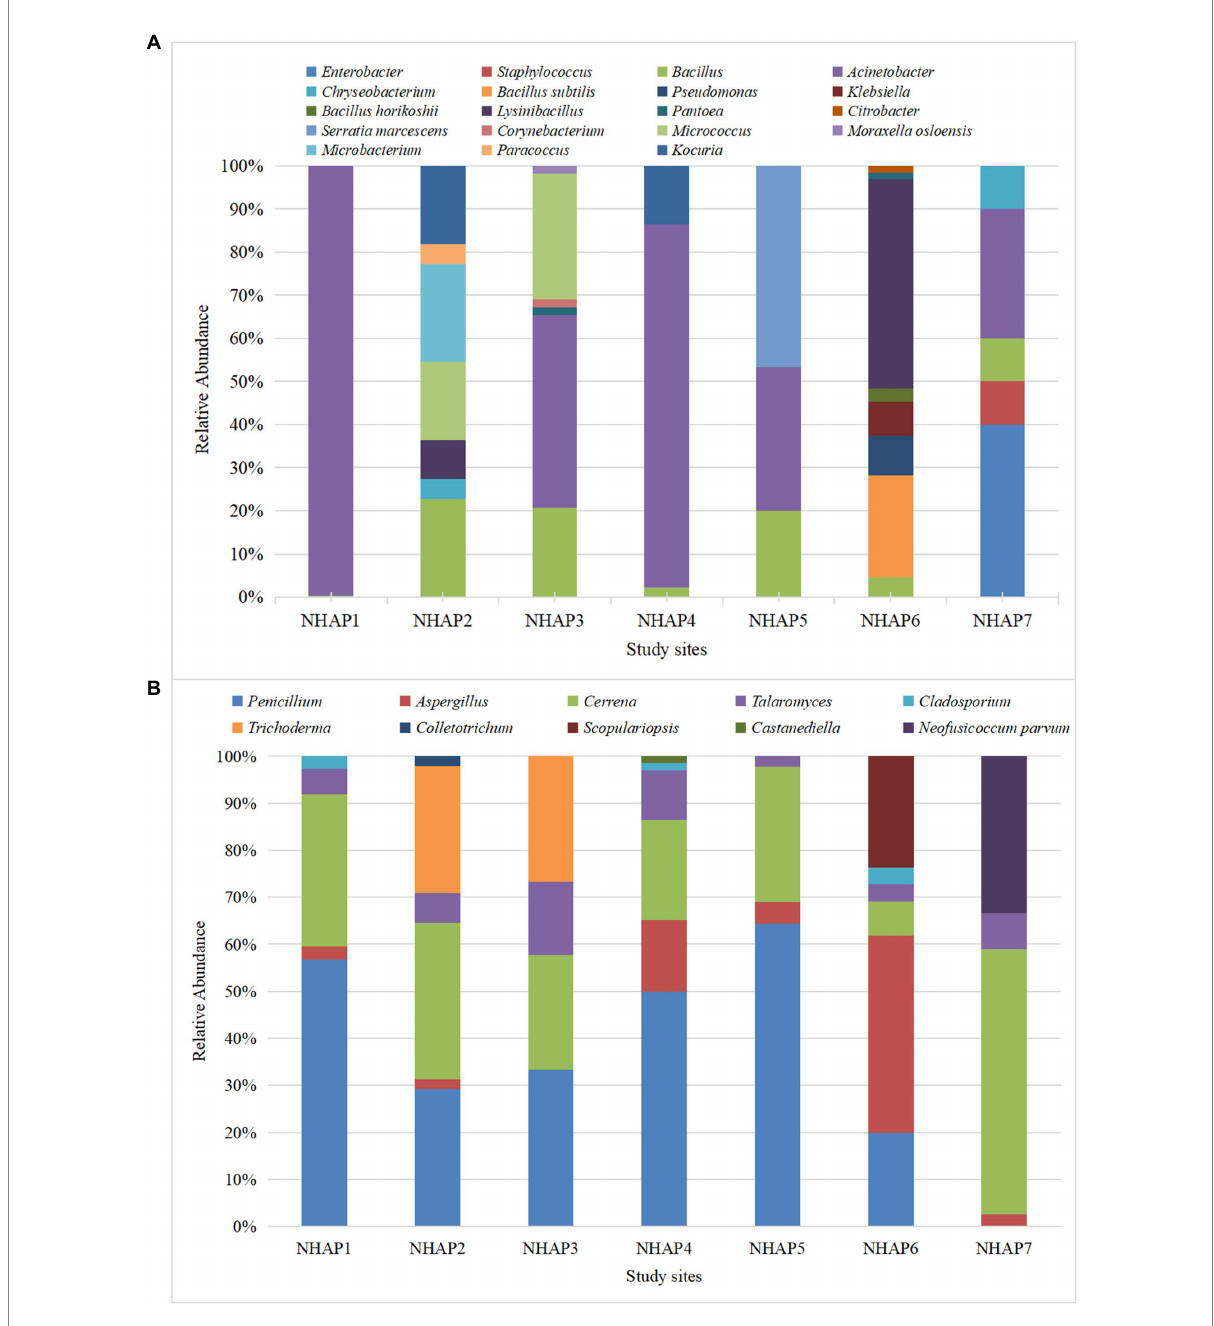
FIGURE 4 Relative abundance of airborne bacteria (A) and fungi (B) at each of the Nanhai No.1 shipwreck sampling sites in